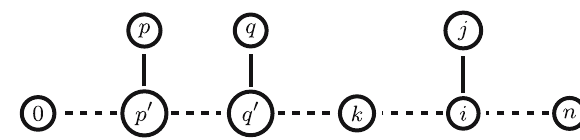
Figure 14: Minimum subgraph of C containing vertices { } p q j k n 0, , , , , , when > p q n , .